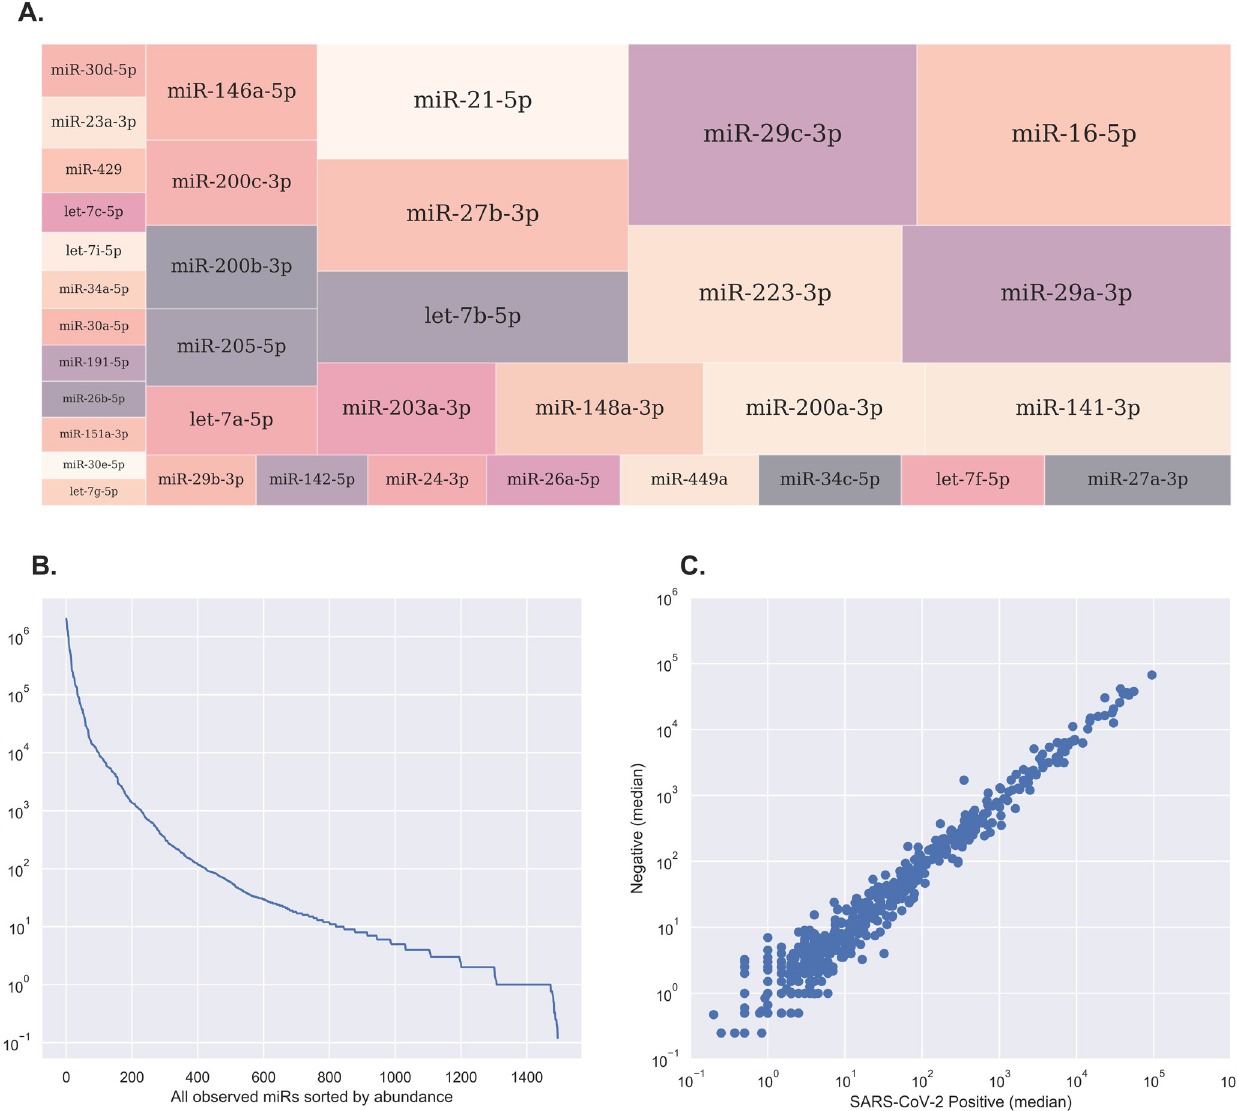
Fig 1. Overview of host-encoded miRNAs in nasal swab samples. A, Treemap plot displaying the relative abundance of the most highly-expressed miRNAs in nasal swab samples. The most prevalent miRNA was miR-16-5p, followed by miR-29a-3p, miR-29c-3p and miR-223-3p. B , Line plot showing the relative abundance of all host miRNAs identified in nasal swab samples. A total of 1495 miRNAs were detected across all 20 samples, of which 452 were detected at greater than 100 reads. C , Scatter plot illustrating inter-sample variance at the single-miRNA level. Each individual point represents a single mature miRNA, shown as the median of DESeq2-normalized read counts in each group and drawn in log 10 scale on both axes. MiRNAs that lie exactly on the diagonal midline have equal expression in both groups, while miRNAs located further away from the midline are potential candidates for differential expression.